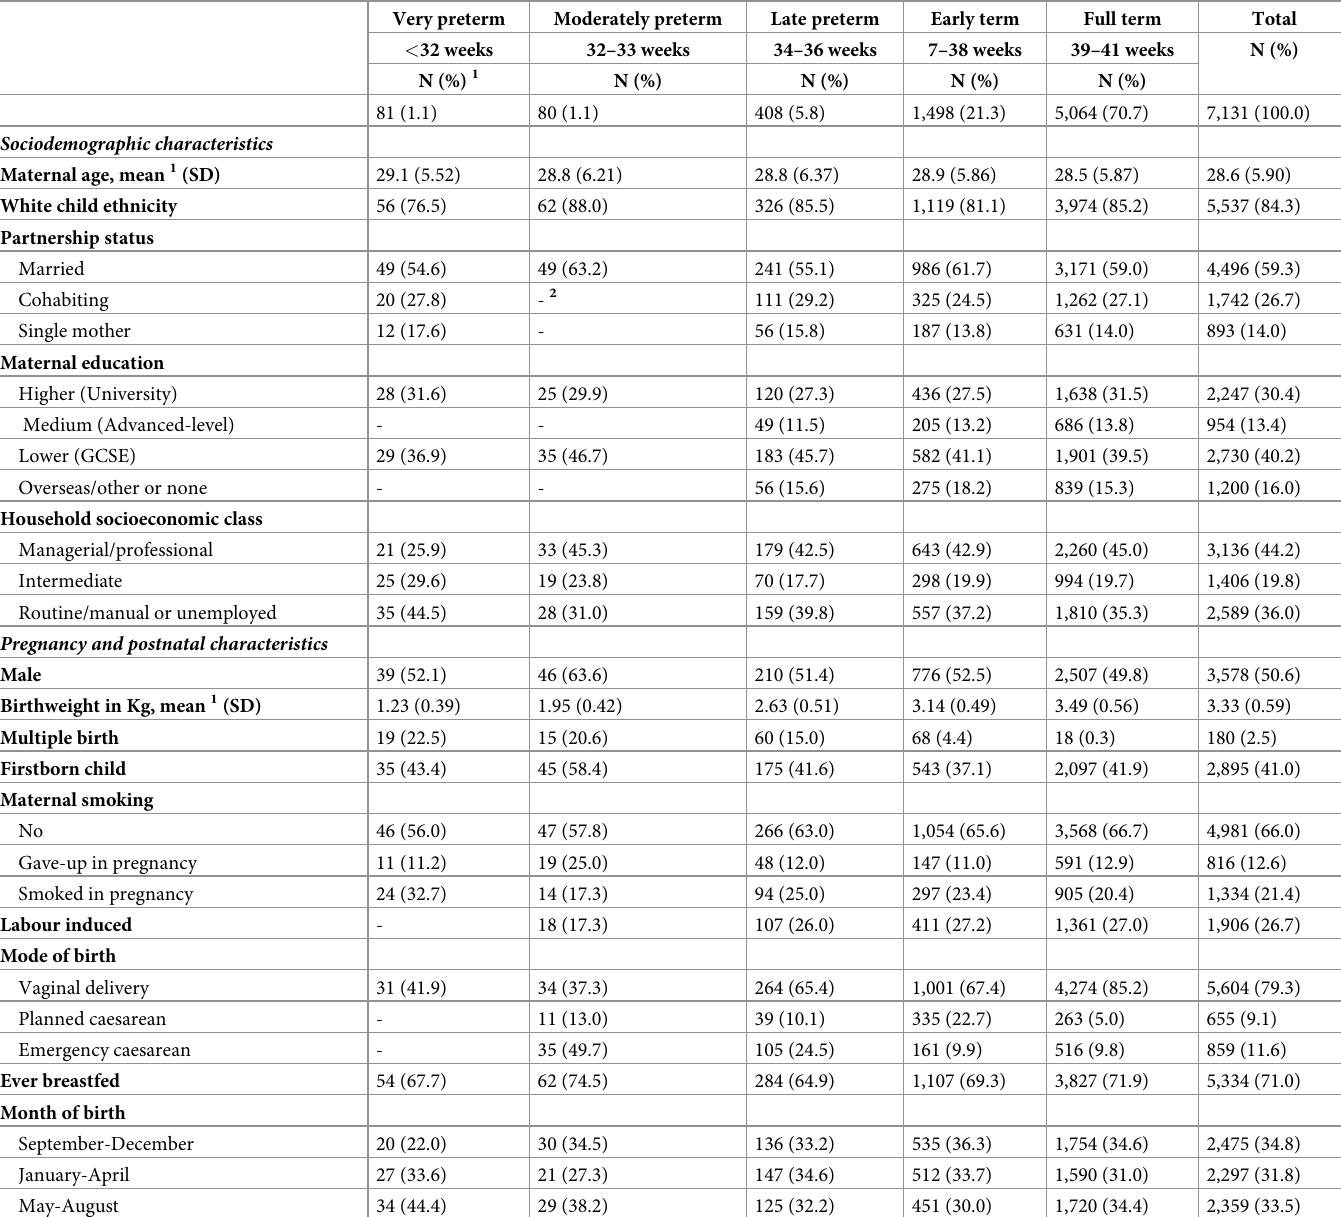
Table 1. Characteristics of the children included in the Key Stage 4 (KS4; secondary school, age 16) analysis study